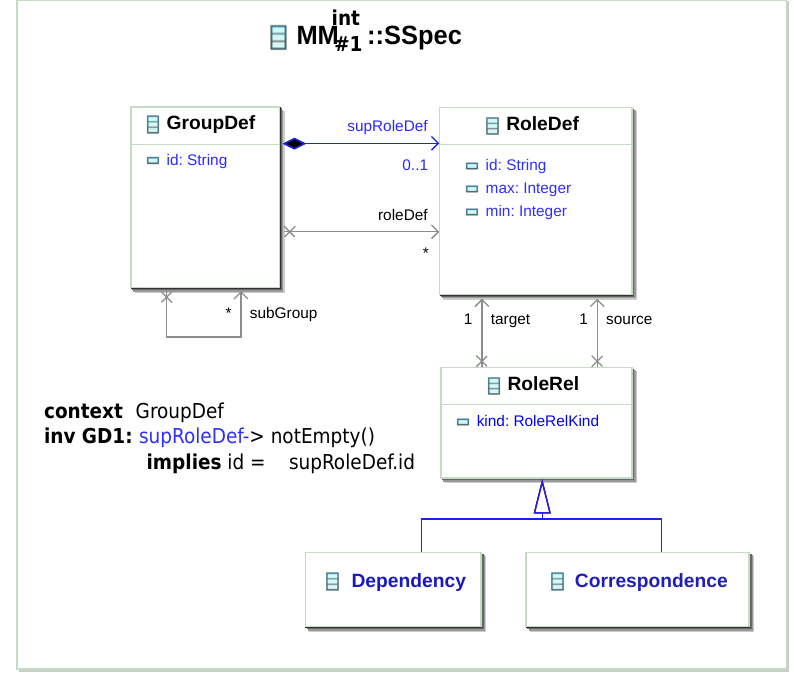
Figure 7. Integrated metamodel MM int